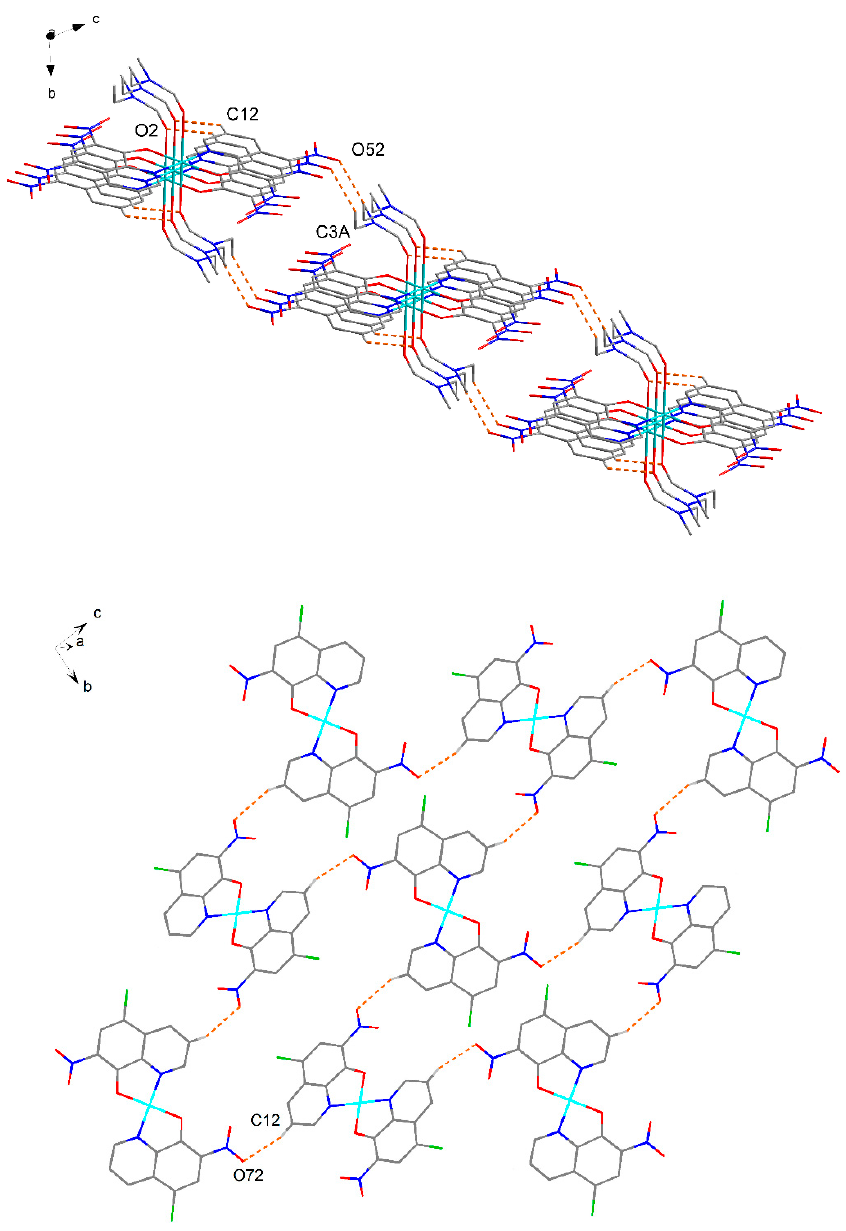
Figure 5. Layers formed by hydrogen bonds (dashed lines) in 5 ( top ) and 6 ( bottom ). Hydrogen atoms not involved in hydrogen bonds are omitted because of clarity.